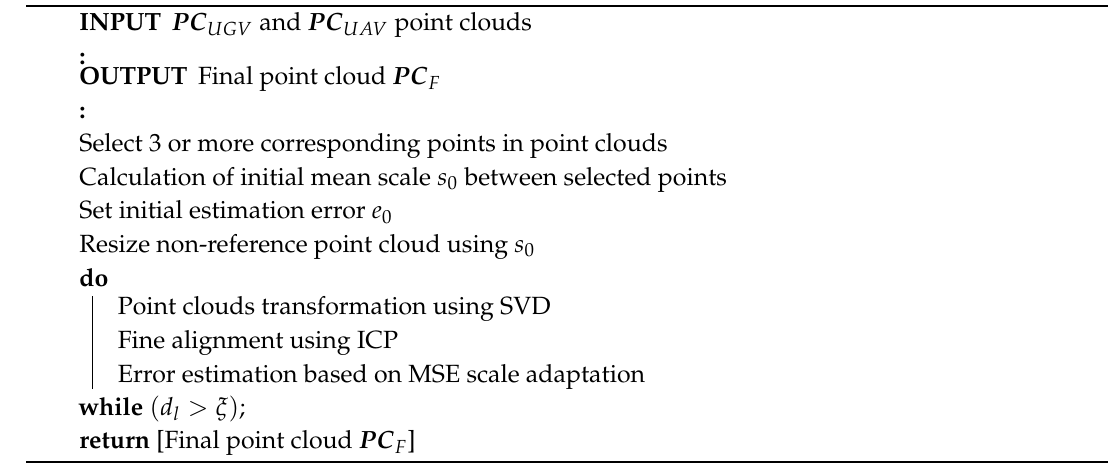
Algorithm 5: Semi-automated 3D registration